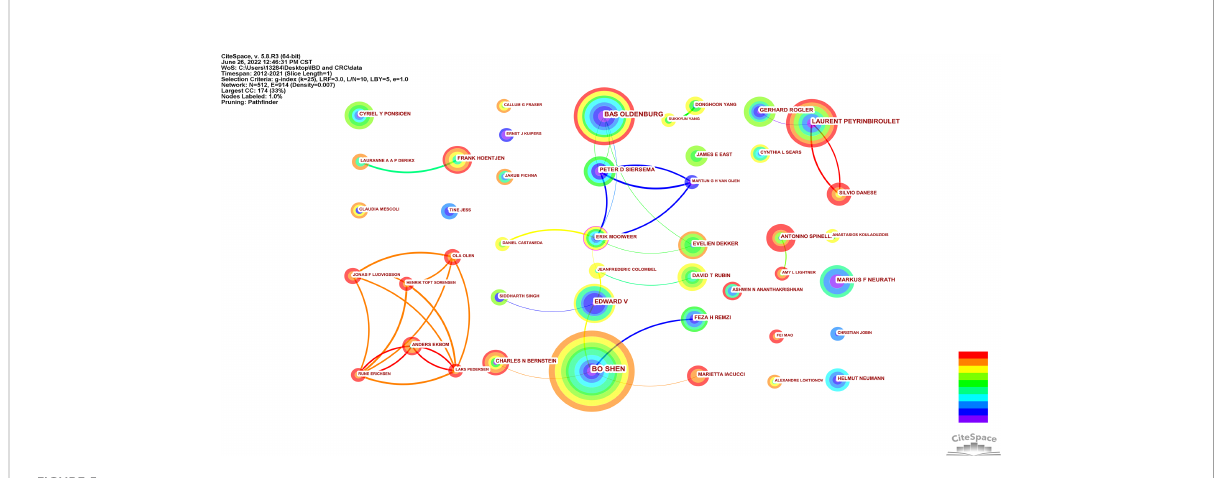
FIGURE 5 Visualization of cooperative relationship of authors with more than 5 articles.